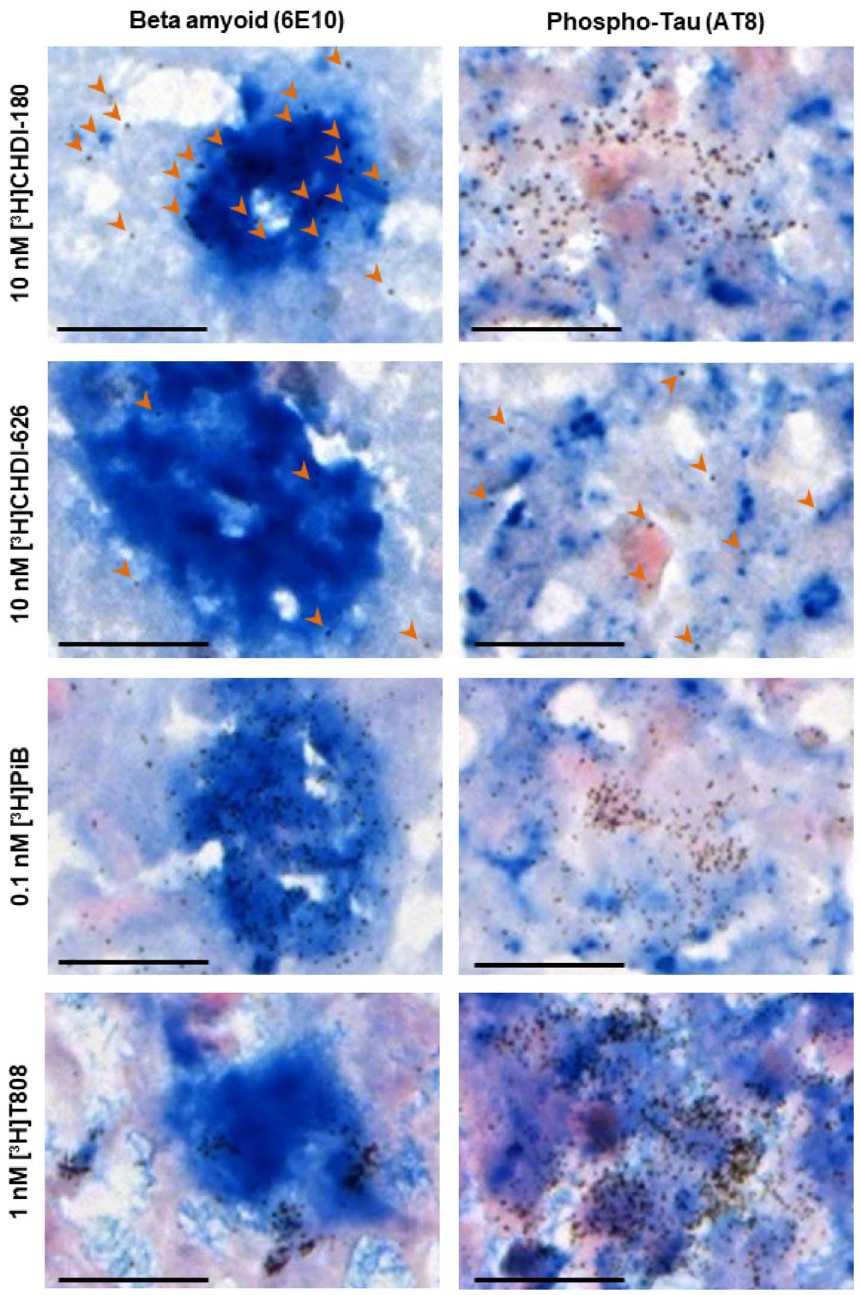
Figure 8. HR ARG studies investigating co-registration of radioligand binding with beta amyloid plaques and phospho-Tau tangles. HR ARG study investigating co-registration of 10 nM [ 3 H]CHDI-180, 10 nM [ 3 H] CHDI-626, 0.1 nM [ 3 H]PiB and 1 nM [ 3 H]T808 with non-HTT fibrillary deposits such as beta amyloid (6E10 antibody) or tau tangles (AT8 antibody). Bound radioligand appears as cluster of silver grains (black dots, orange arrow heads indicate individual silver grains in tissue with low levels of bound radioligand); 6E10- and AT8-positive staining is indicated as blue signal, background was stained with Nuclear Fast red and shows a pink color. Scale represents 20